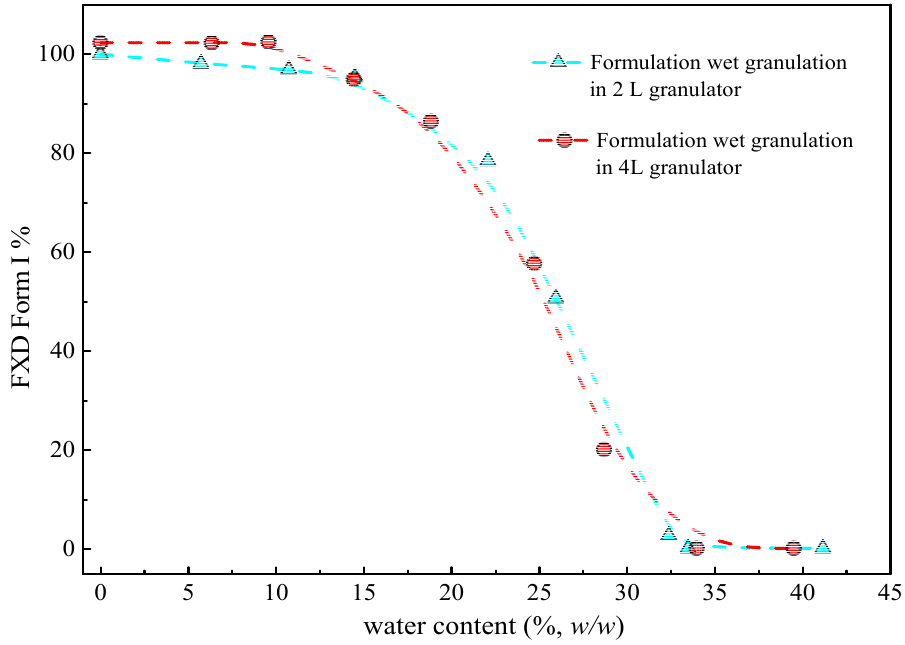
Figure 6. Percentage of FXD Form I as a function of water content in 2 L and 4 L granulators by DSC during wet granulation formulation. The line is drawn to assist in visualizing the trend.